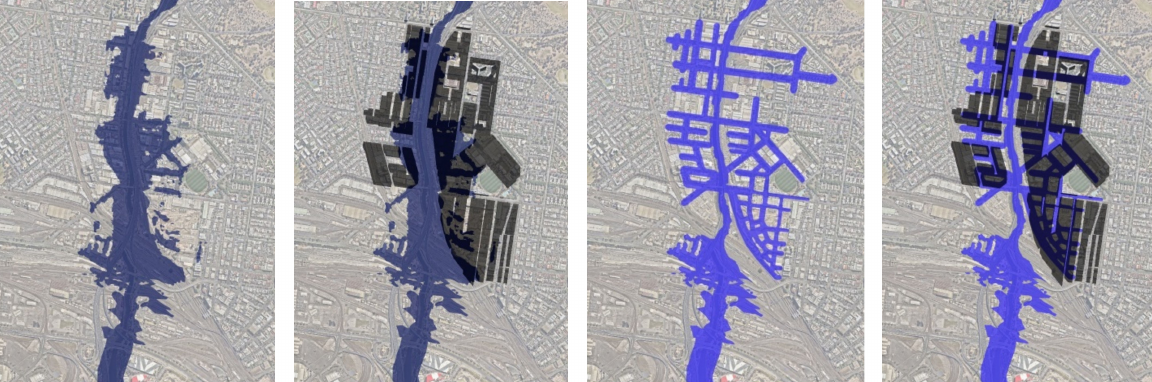
Figure 7. LEFT Map of Flood scenario 01: ‘Land subject to inundation’ flood zone as modelled by Melbourne Water 2016 with no infrastructure changes and overlayed on the 12:30 mid-winter building overshadowing map RIGHT map showing Flood scenario 02: ‘Road-based integrated water management’ Surface storm water infrastructure within the street casement overlayed with the 12:30 mid-winter building overshadowing